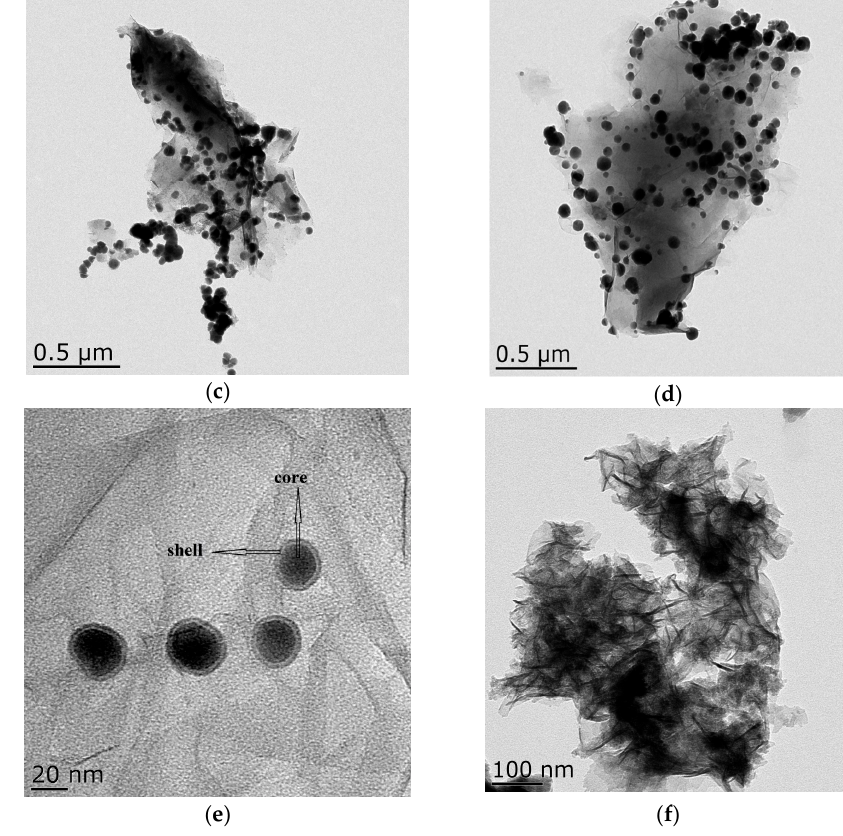
Figure 4. Lorentz-Transmission Electron Microscope (TEM) images of ( a ) bentonite, ( b ) GO, ( c ) B-nZVI, ( d ) GO-B-nZVI, ( e ) core–shell structure of nZVI, and ( f ) GO-B-nZVI after the removal of copper ions.